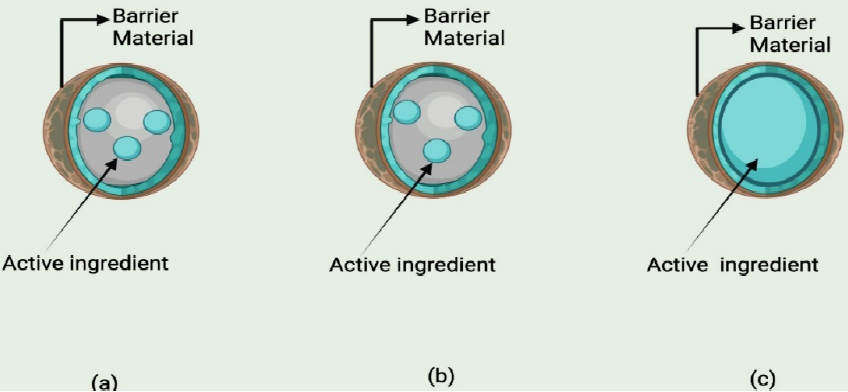
Figure 9. ( a ) Spray ‐ dried flavor technology ( b ) Matrix encapsulated flavors ( c ) Core ‐ shell encapsu ‐